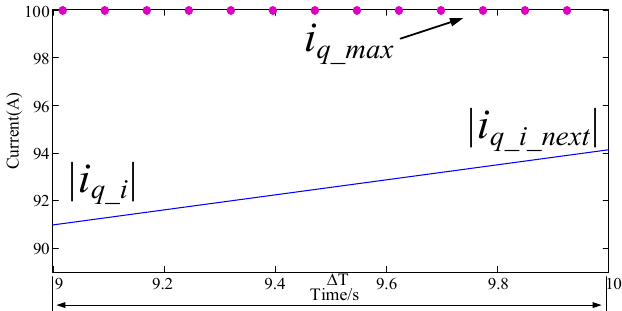
Figure 12. Prevention of overcurrent during discharging.